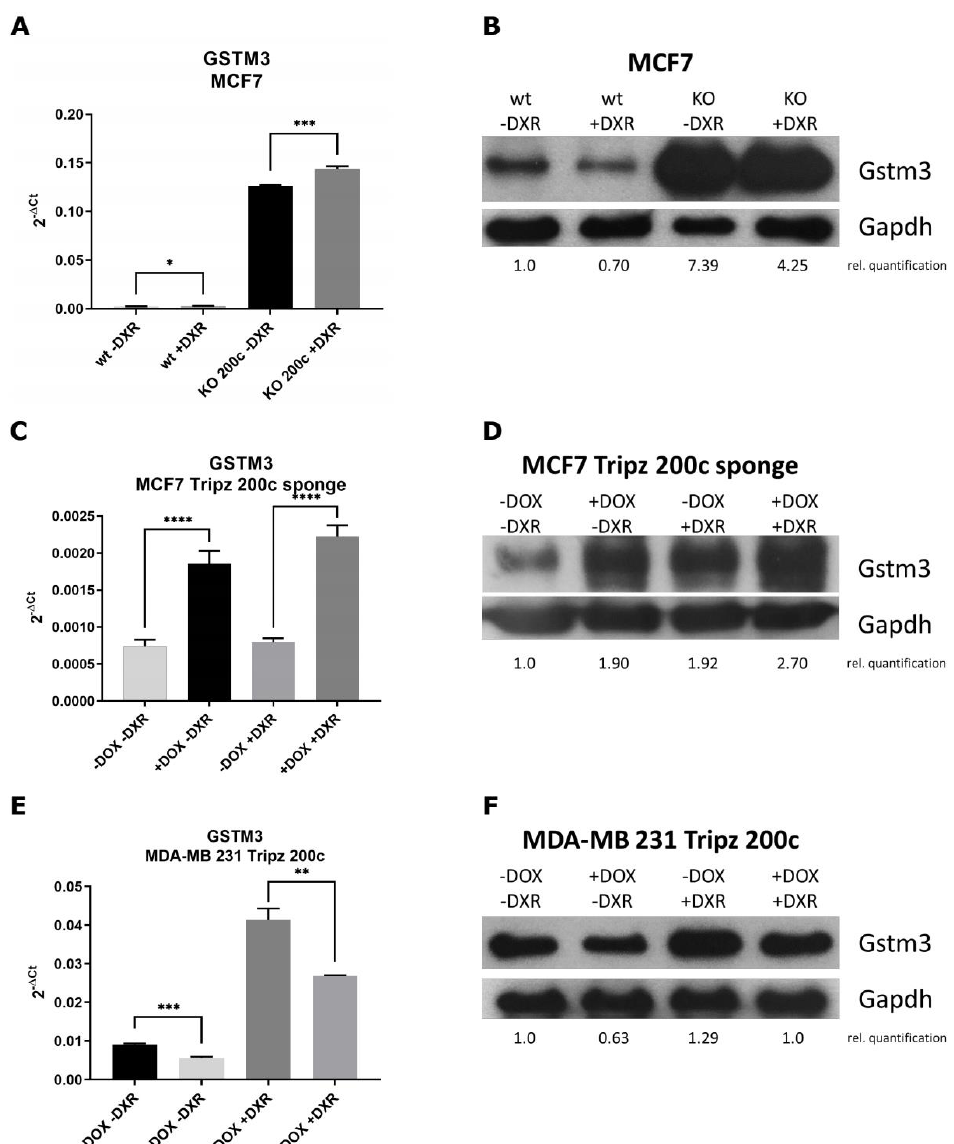
Figure 4. qRT-PCR and Western blot analysis of GSTM3 upon chemotherapeutic treatment. ( A,B ) MCF7 wt vs. MCF7 KO 200 c cell line treated with 5 µM DXR for 6 h. ( C,D ) MCF7 Tripz 200 c sponge cell line with or without DOX induction for 72 hours and subsequent DXR treatment with 0.1 µM for 24 h. ( E,F ) MDA-MB 231 Tripz 200 c cells with or without DOX induction (72 h) and subsequent DXR treatment with 0.6 µM for 24 h. For Western blot quantification, contrast ratios were analyzed. An unpaired two-tailed Student ’ s t-test was performed for qRT-PCR statistics. One representative replicate out of three is shown. * p < 0.05, ** p < 0.01, *** p < 0.001, **** p < 0.0001. Values are displayed as mean with SD.